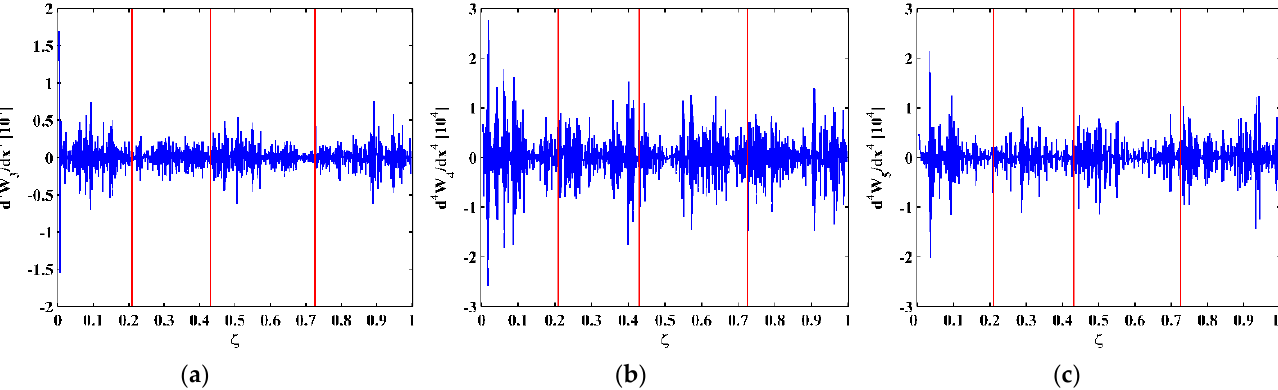
Figure 15. Derivatives of the ( a ) third, ( b ) fourth, and ( c ) fifth mode shapes (locations of cracks are indicated by red lines).